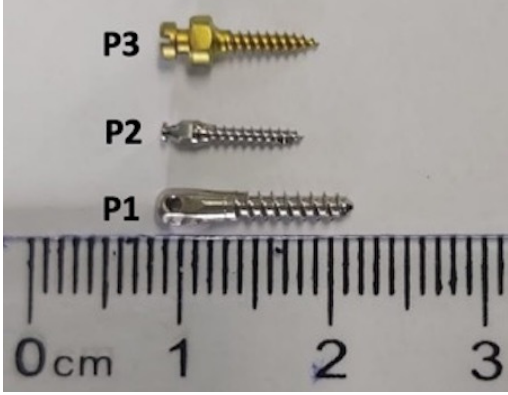
Figure 1. Representative image of test orthodontic implants.